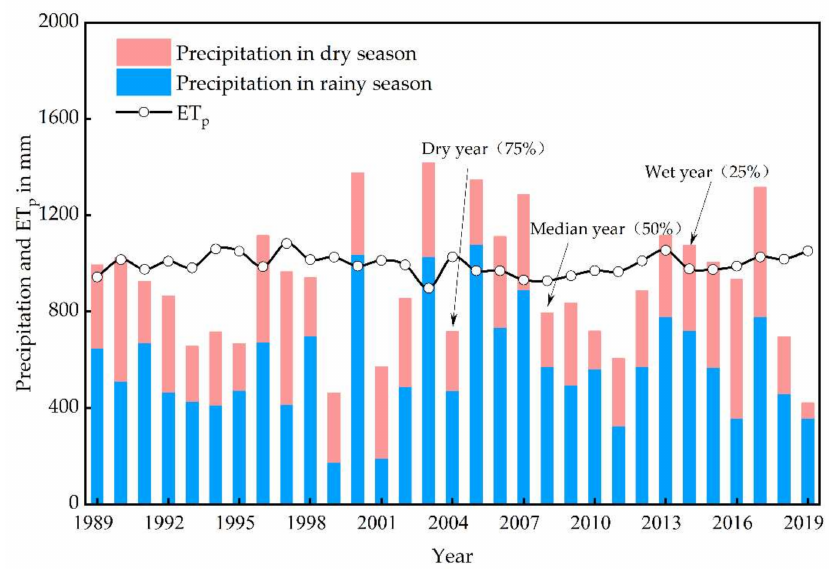
Figure 2. Annual precipitation measurements from Lixin County Meteorological Station and annual ET p from Bozhou city Meteorological Station from 1989 to 2019 (refer to Section 3.2.2 for the selection of different hydrological